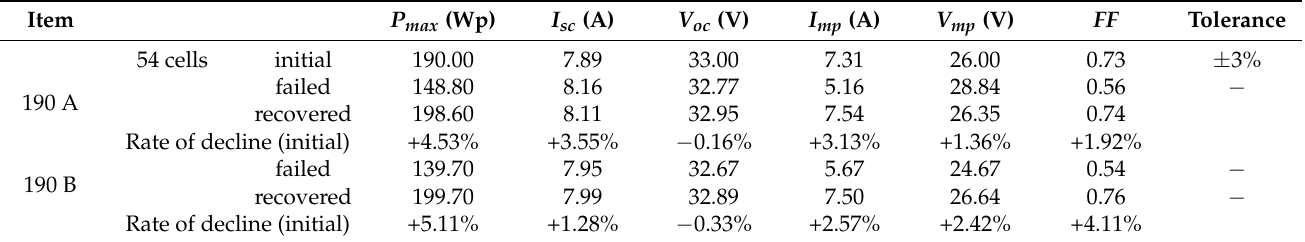
values of the power degradation module owing to cell cracking. Table 9. Electrical data deviation of initial, faulty, and recovered